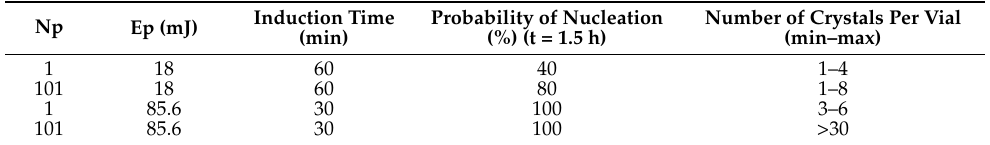
Table 1. Influence of the number of pulse and its intensity on the nucleation behavior of K 2 SO 4 solutions at β =1.25. Np is the number of pulses; Ep is the intensity or pulse energy.